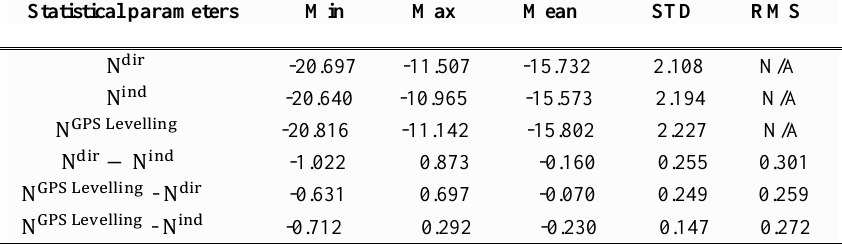
Table 4. The statistical parameters of the comparison of the geoidal height in direct and indirect methods with geometric geoidal height of GNSS_Levelling stations, unit: meter.